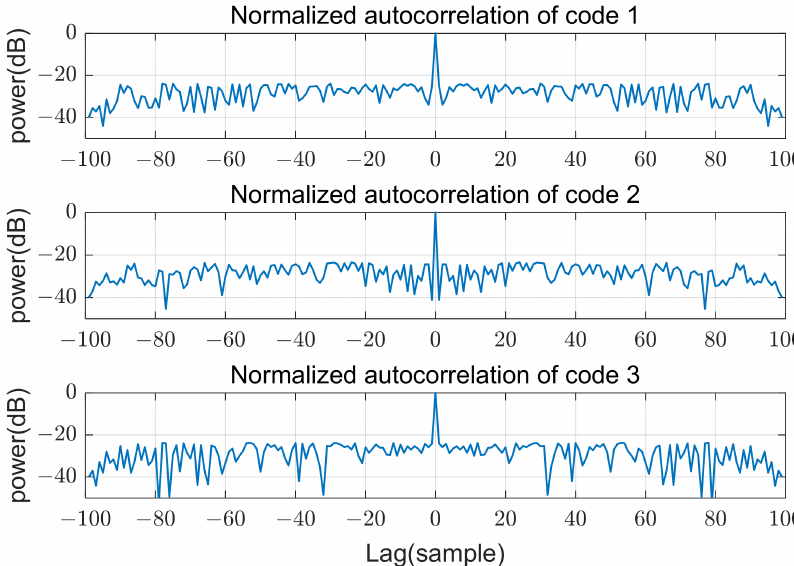
Figure 6. Normalized autocorrelation of codes.